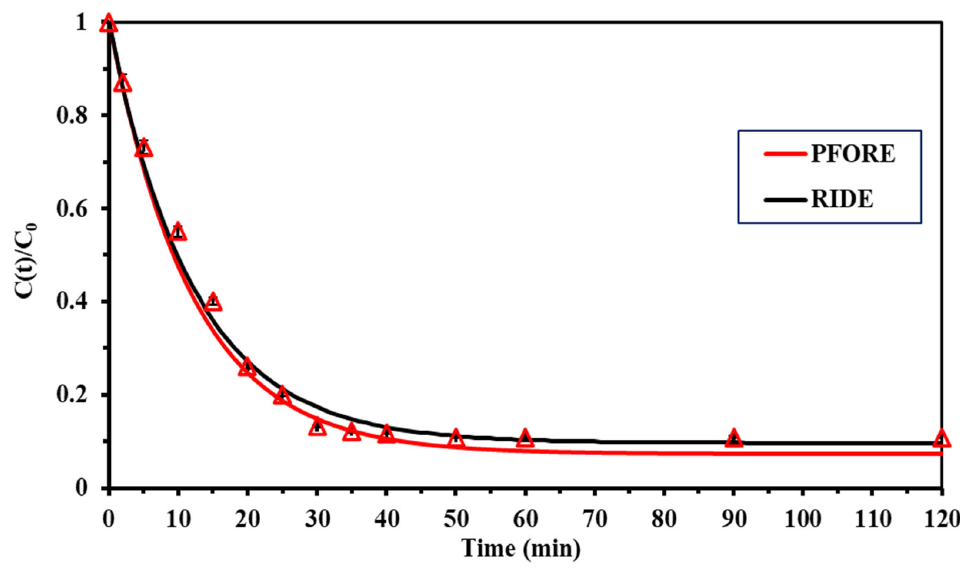
Figure 7. Uptake Kinetic models PFORE and RIDE that fitted the experimental data. Hubbe et al. [74] concluded that the PSORE in a lot of cases was inferred with the control of mass transfer through resistance to intraparticle diffusion. Simonin [75]